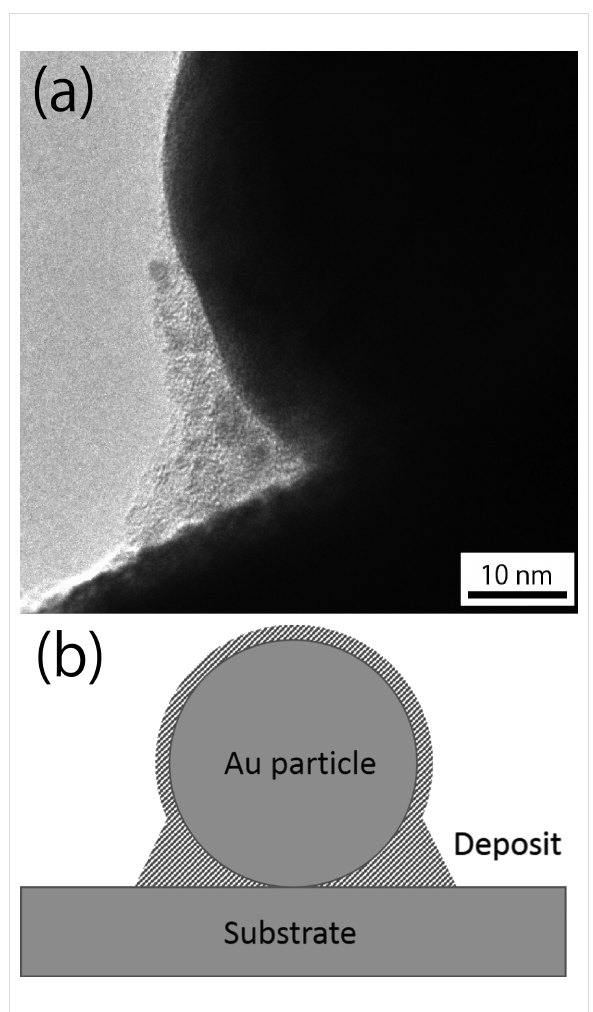
Figure 6: TEM image of the amorphous deposit formed around/ between the particle and the substrate (a), and schematic illustration of the immobilization mechanism